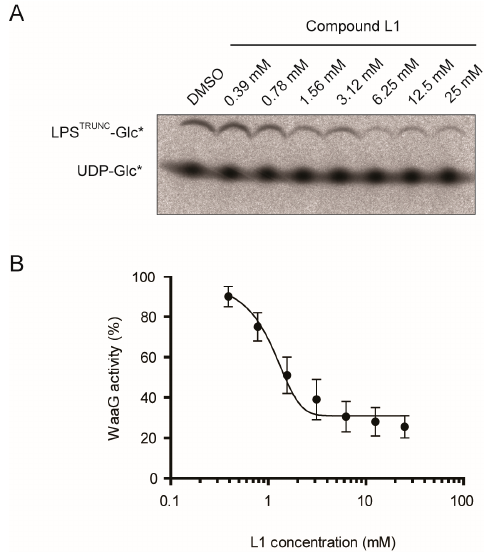
Figure 4. Dose-response curve for compound L1. ( A ) To evaluate the IC 50 , the activity of His-WaaG was assayed in the presence of 20 mM CHAPS, 10 mM PG, 1 mM CL and different concentrations of L1. Samples were collected after 1 h and inactivated by adding Laemmli buffer. The products were separated by SDS-PAGE, detected by digital autoradiography and quantified by densitometry. The IC 50 was calculated as the midpoint between the DMSO control (which was assumed to be 100% activity) and the activity at 25 mM of L1 (which was assumed to be 0% activity). ( B ) His-WaaG activity is shown as a function of L1 concentration. The resulting IC 50 value for compound L1 was calculated to be 1.0 mM ( n = 2).